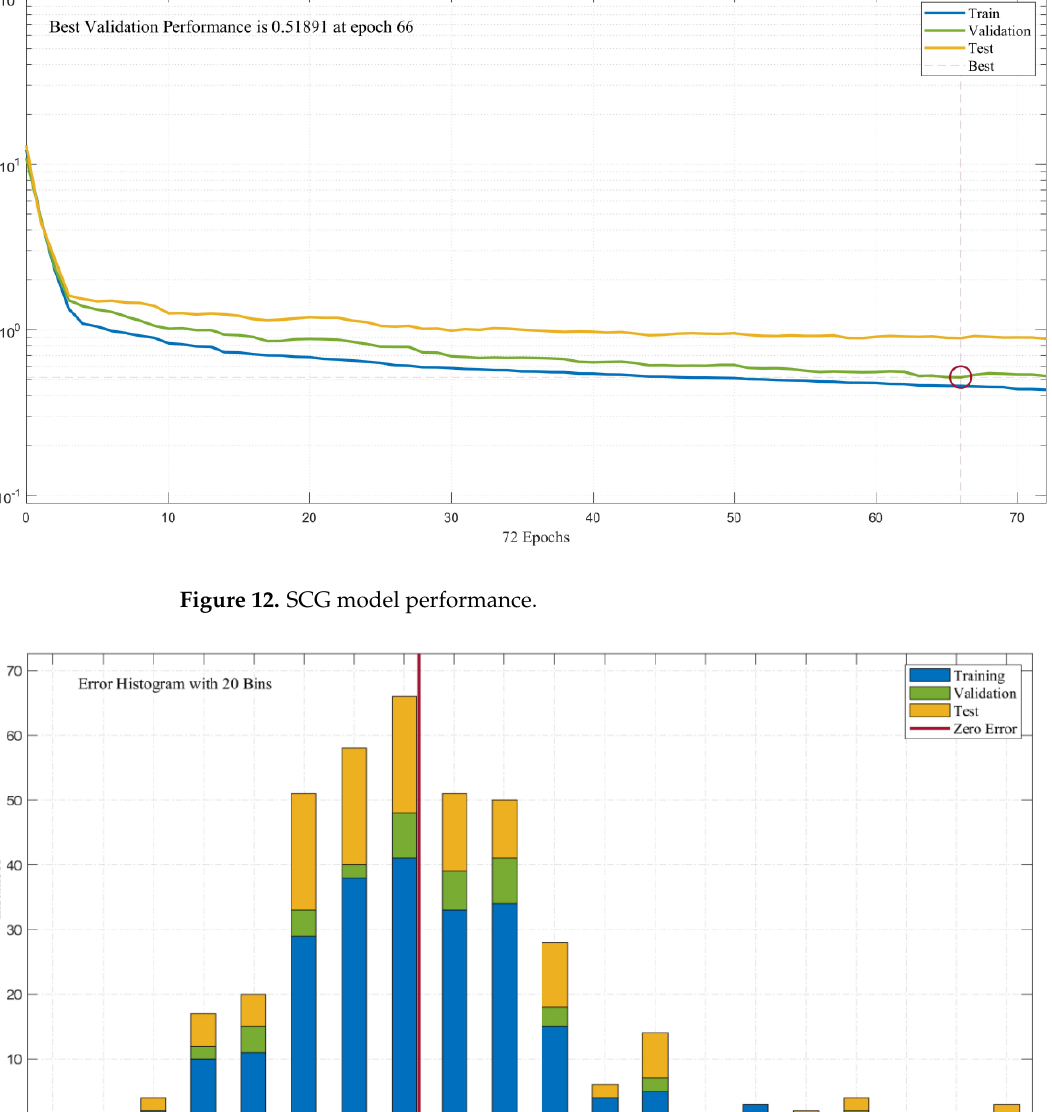
13 of 22 Figure 11. Bayesian regularization regression graphs between the experimental and predicted ten- sile strength: ( a ) training, ( b ) testing, and ( c ) overall dataset. Table 5. Summary of different model evaluation parameters of BR. Step